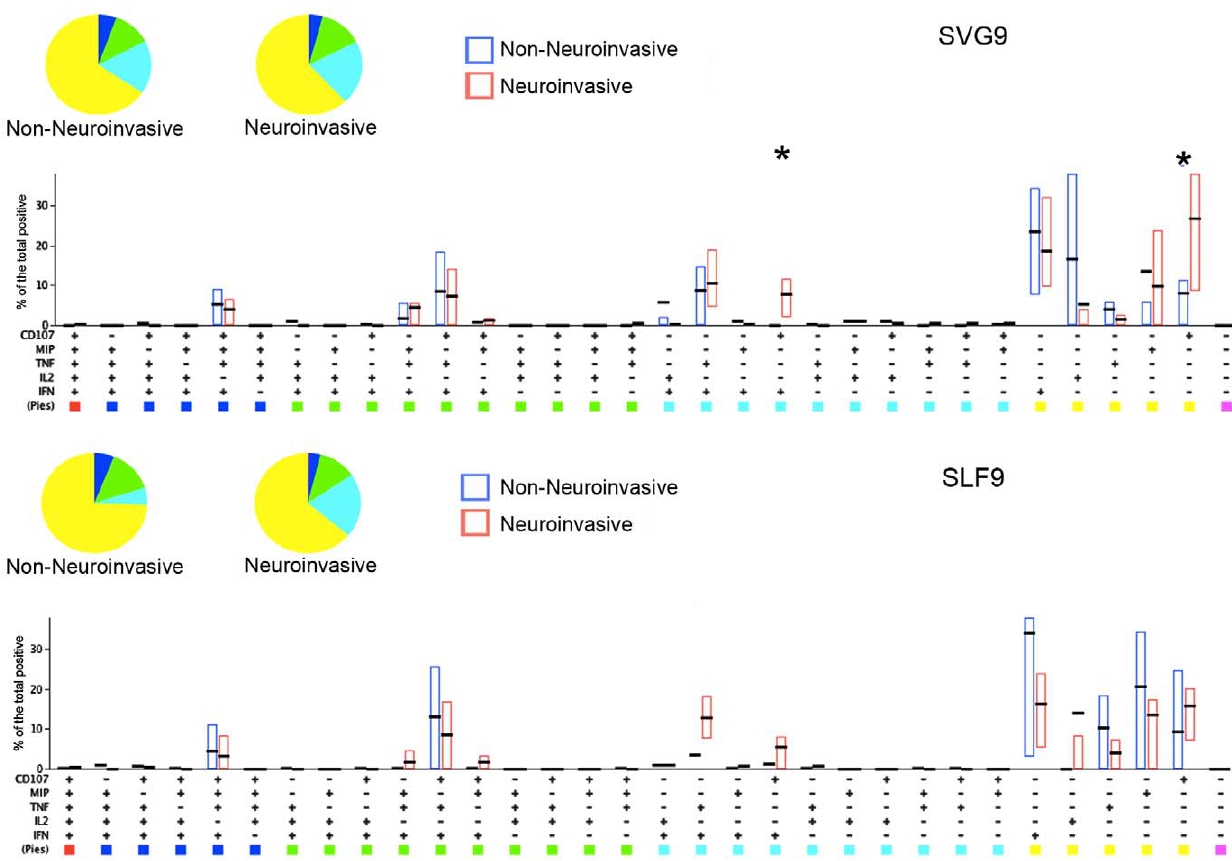
Figure 6. Responses of CD8 + cells stimulated with the SGV9 or SLF9 WNV peptide epitopes are predominantly monofunctional. PBMC from subjects with or without neuroinvasive disease were stimulated with the immunodominant SVG9 or subdominant SLF9 WNV peptide epitopes and functional responses were evaluated by multi-color flow cytometry. Percentages of CD8 + T cells expressing the markers shown were input in the SPICE software for display. Pies represent the distribution of responses by function for each group according to the color scheme below. Bars represent the level of response for each individual of the 32 different marker combinations. Asterisks indicate significant differences (p , 0.05) by Wilcoxon signed -rank test.